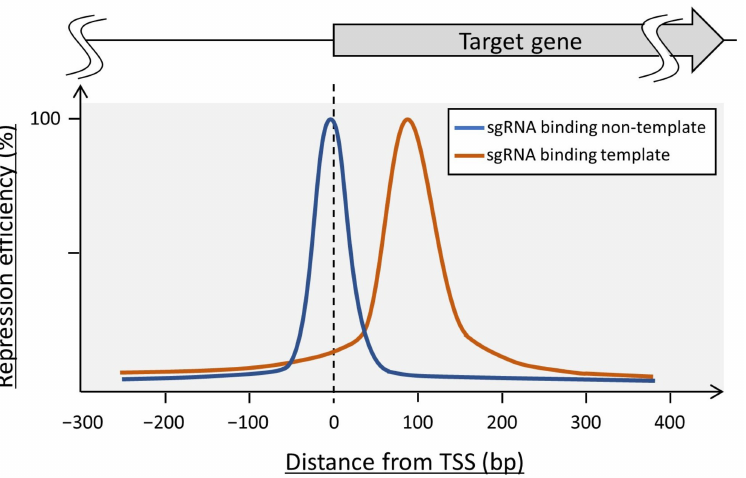
Figure 2. sgRNA design for dCas9-mediated CRISPRi in S. pombe . Transcriptional repression ef- ficiency as a function of distance from TSS is shown. Blue and red lines schematically indicate previously reported results of dCas9-mediated CRISPRi for ade6 + and ura4 + genes [33]. Blue line indicates results with sgRNAs that bind to the non-template strand; Red line indicates results with sgRNAs that bind to the template